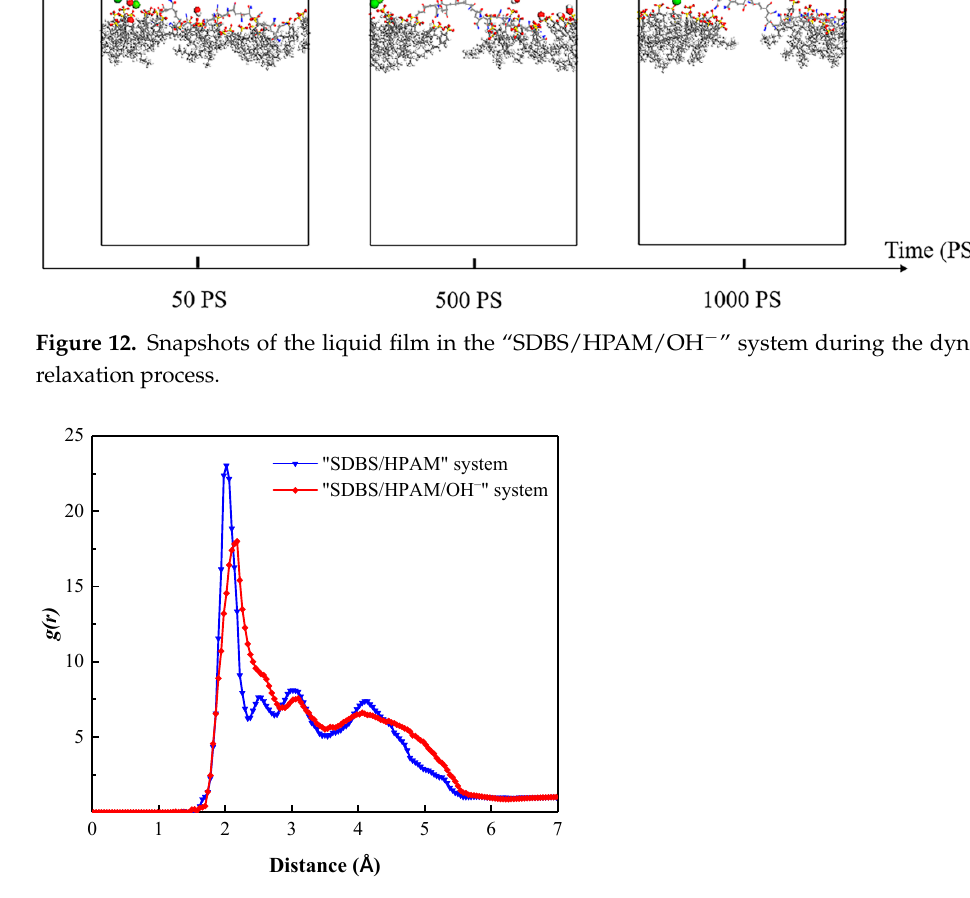
Figure 12. Snapshots of the liquid film in the “SDBS/HPAM/OH − ” system during the dynamic re- laxation process.